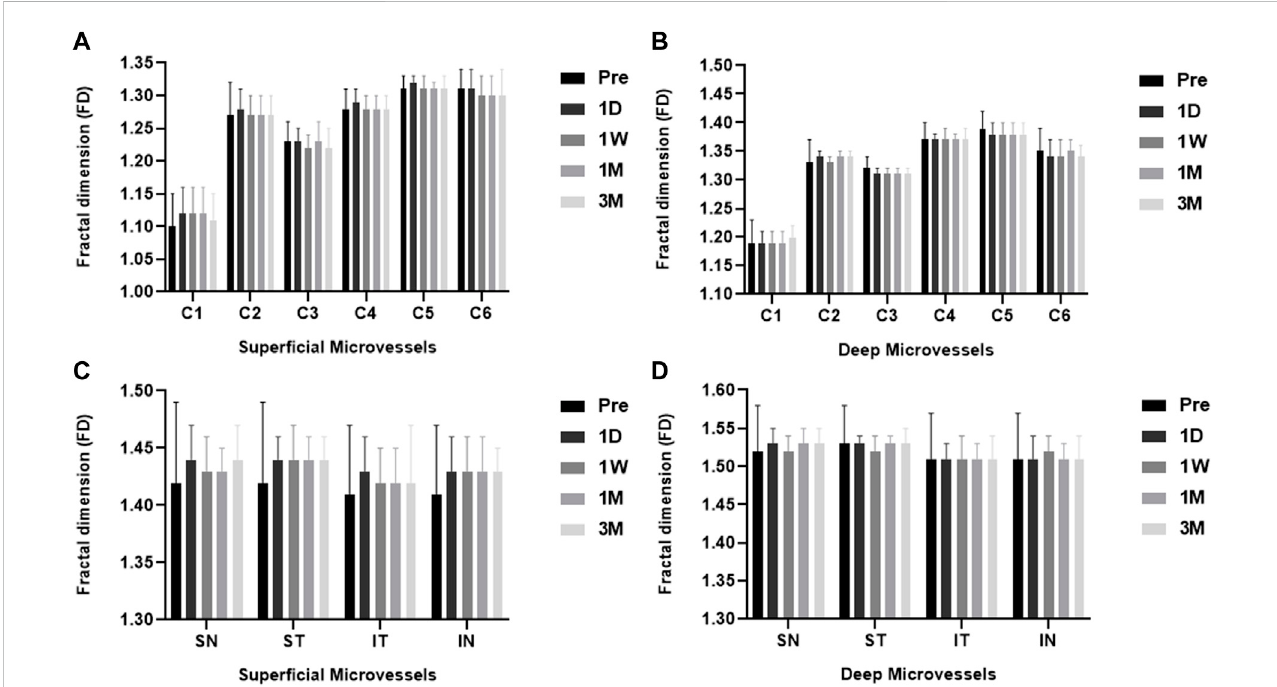
FIGURE 4 TheFD(representingretinalmicrovasculardensity)ofICLpatientspre-andpost-surgeryforeachlayer.Amongthesixindividualannularzones (A,B) ,the microvascular density in the (A) super fi cial and (B) deep layers showed no signi fi cant difference in myopia patients pre- and post-surgery (all p > 0.05). The microvascular density was also not signi fi cantly different in all quadrantal zones of the super fi cial (C) and deep (D) layers in myopia patients pre-and post- surgery. (all p > 0.05). ST, superior temporal; SN, superior nasal; IN, inferior nasal; IT, inferior